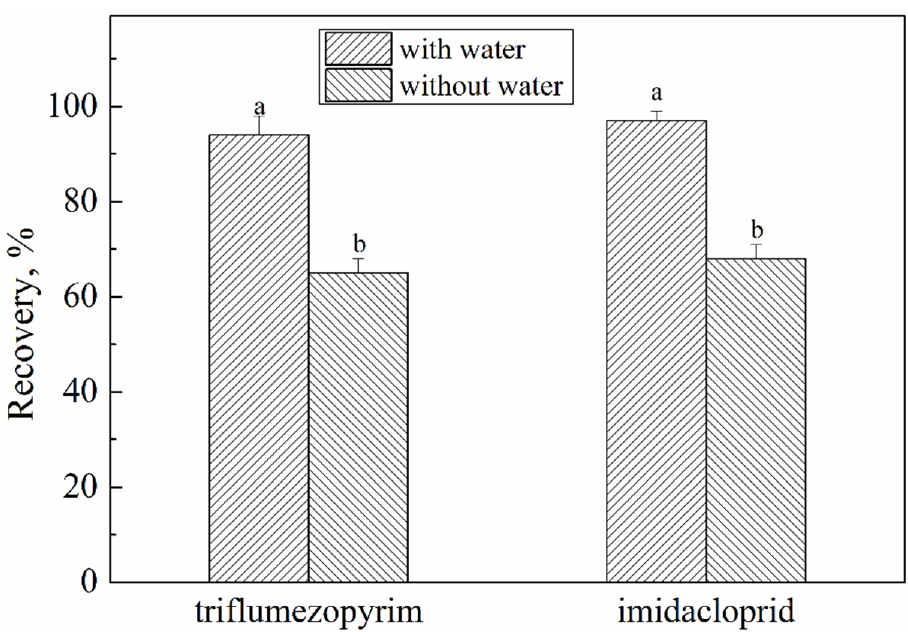
Figure 2. Effect of different extraction methods with and without water on recovery. The letters (a and b) indicate a significant difference at the 1% level.